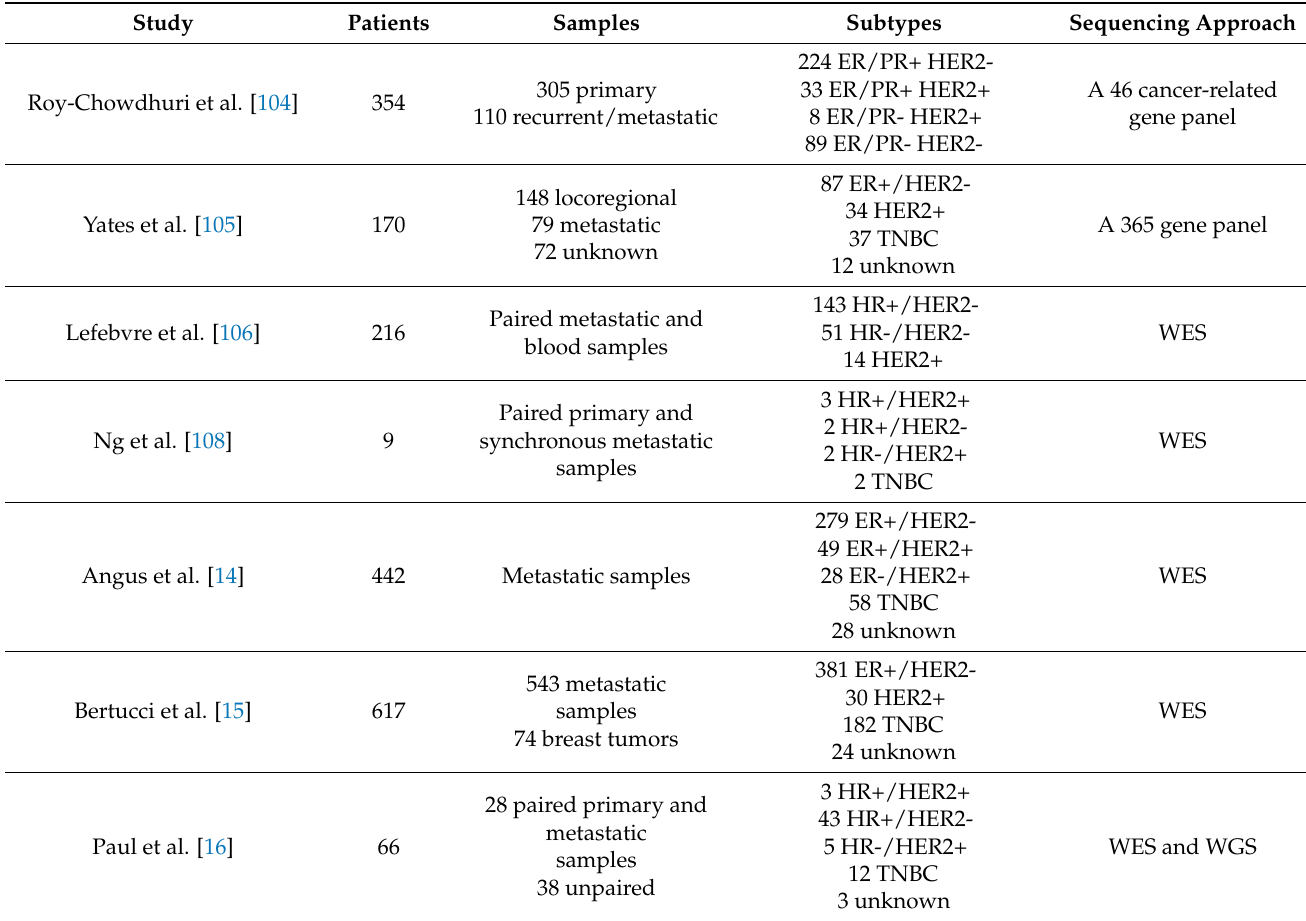
Table 1. Studies on the genomic landscape of metastatic breast